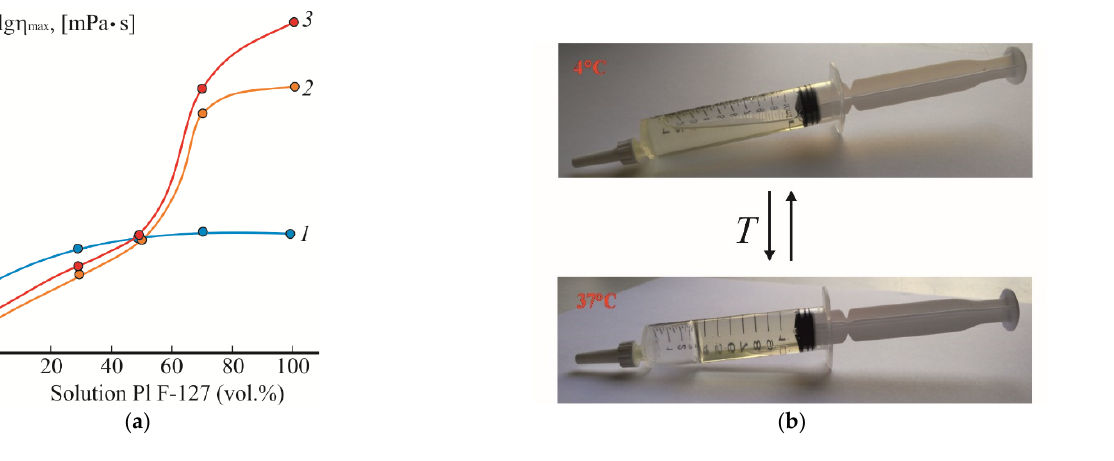
Figure 3. ( a ) Dependence of the highest Newtonian viscosity of the same CS · HCl and Pl F-127 solutions and CS · HCl:Pl F-127 mixtures, as in Figure 2, on the volume fraction of Pl F-127 at 4 ( 1 ), 25 ( 2 ) and 37 ◦ C ( 3 ). ( b ) Photos of the phase state of the CS · HCl:Pl F-127 = 30:70 (vol./vol.) mixture with C CS · HCl = 3 wt.% and C Pl F-127 = 25 wt.% when temperature changes.